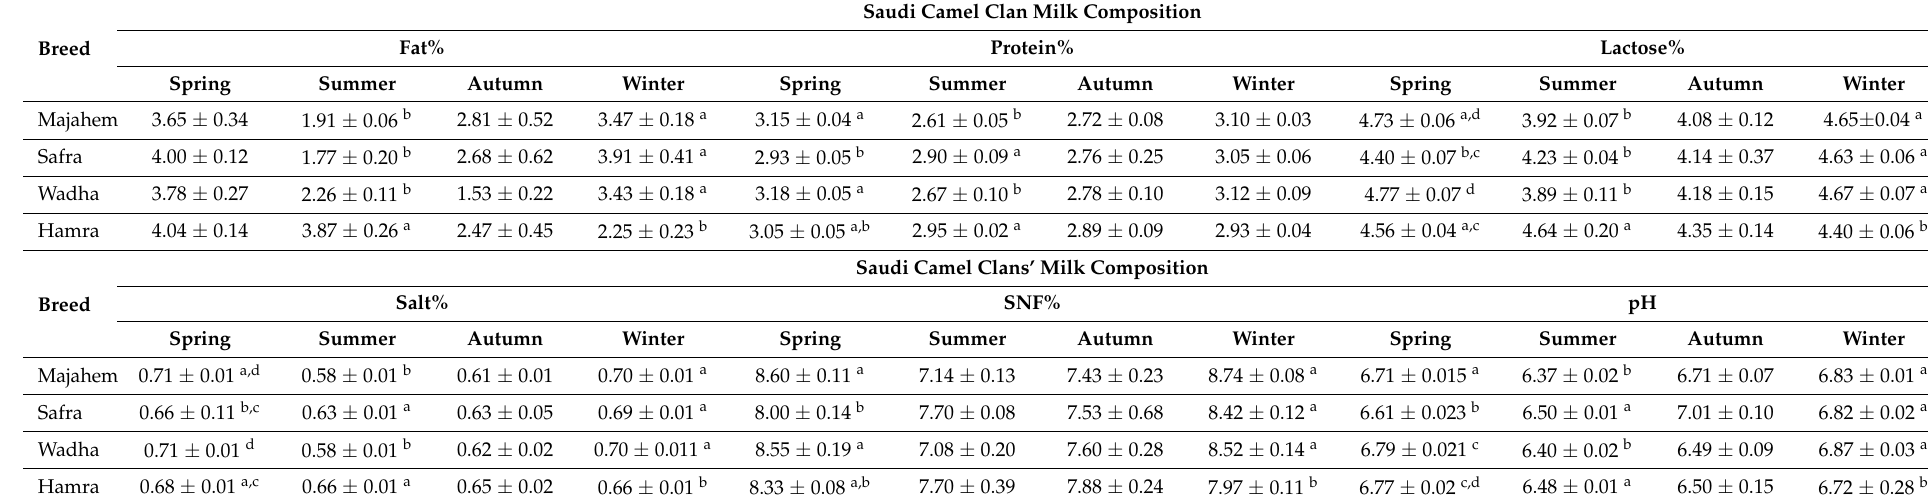
Table 2. Variability of milk composition (mean ± SE) of different Saudi camel breeds in summer, winter, spring, and autumn seasons over 12 months. Saudi Camel Clan Milk Composition Fat% Protein% Breed